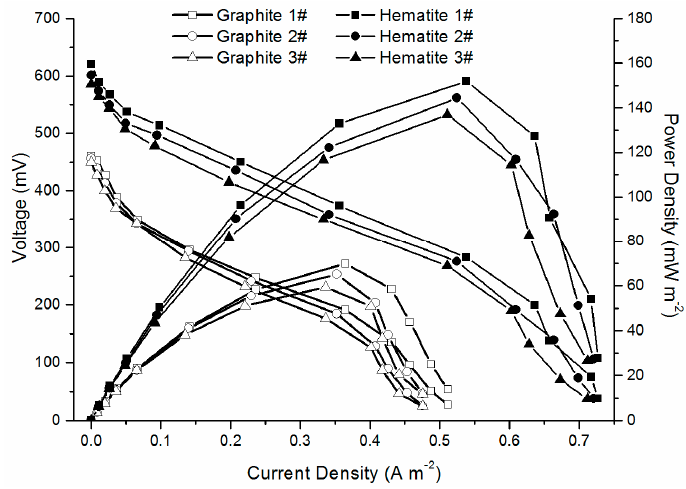
Figure 4. Polarization and power density curves of MFCs equipped with natural hematite and graphite cathodes in three typical batches.